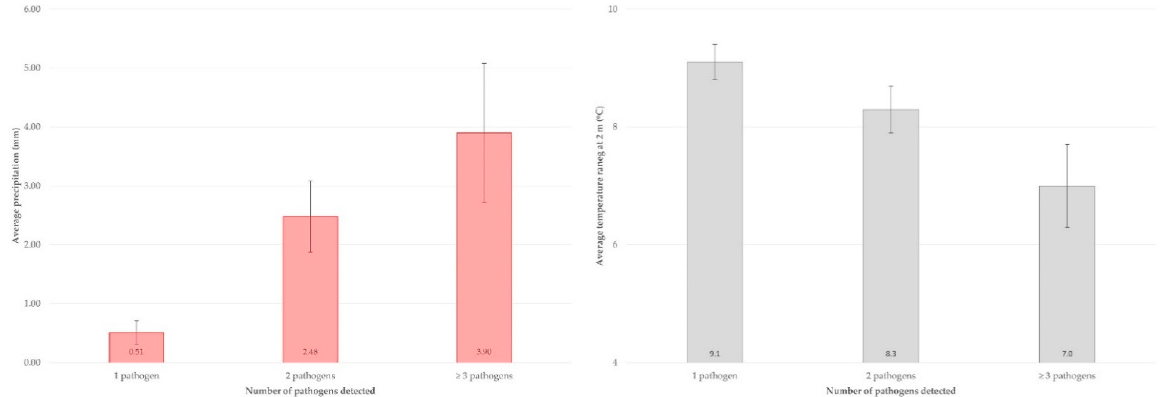
Figure 1. Average precipitation (left histogram) and average temperature at 2 m (right histogram) in the locations of goat farms for the 15 days prior to sampling in accord with the number of patho ‐ gens recovered in faecal samples from these